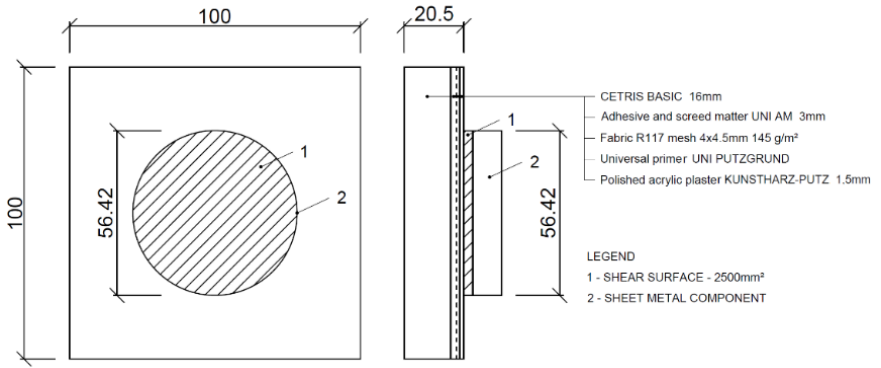
Figure 1. Test specimen for tensile test.